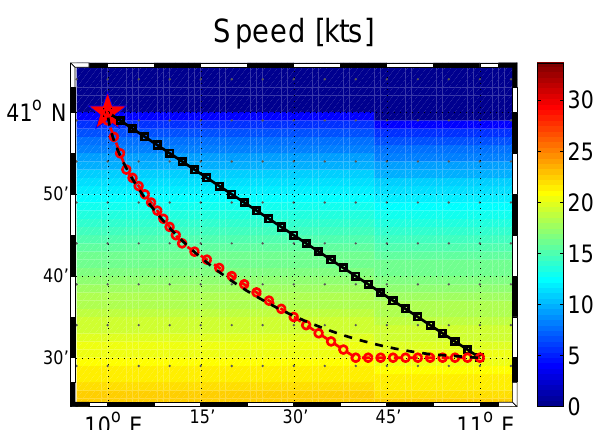
Figure 9. Cycloidal benchmark: vessel speed v(x,y) √ 2 g( 2 R y) is shown as a colour background field (the fea- − ture at about 10 ◦ 45 (cid:48) E is due to the projection into spherical coordinates of a speed field constant along the x linear coordinate). The geodetic and the optimal routes are displayed with squared black and circular red markers respectively. The analytical solution Eq. (50) (inverted cycloid) is plotted as a dashed black line. The length and duration of these three routes are compared in Table 10.